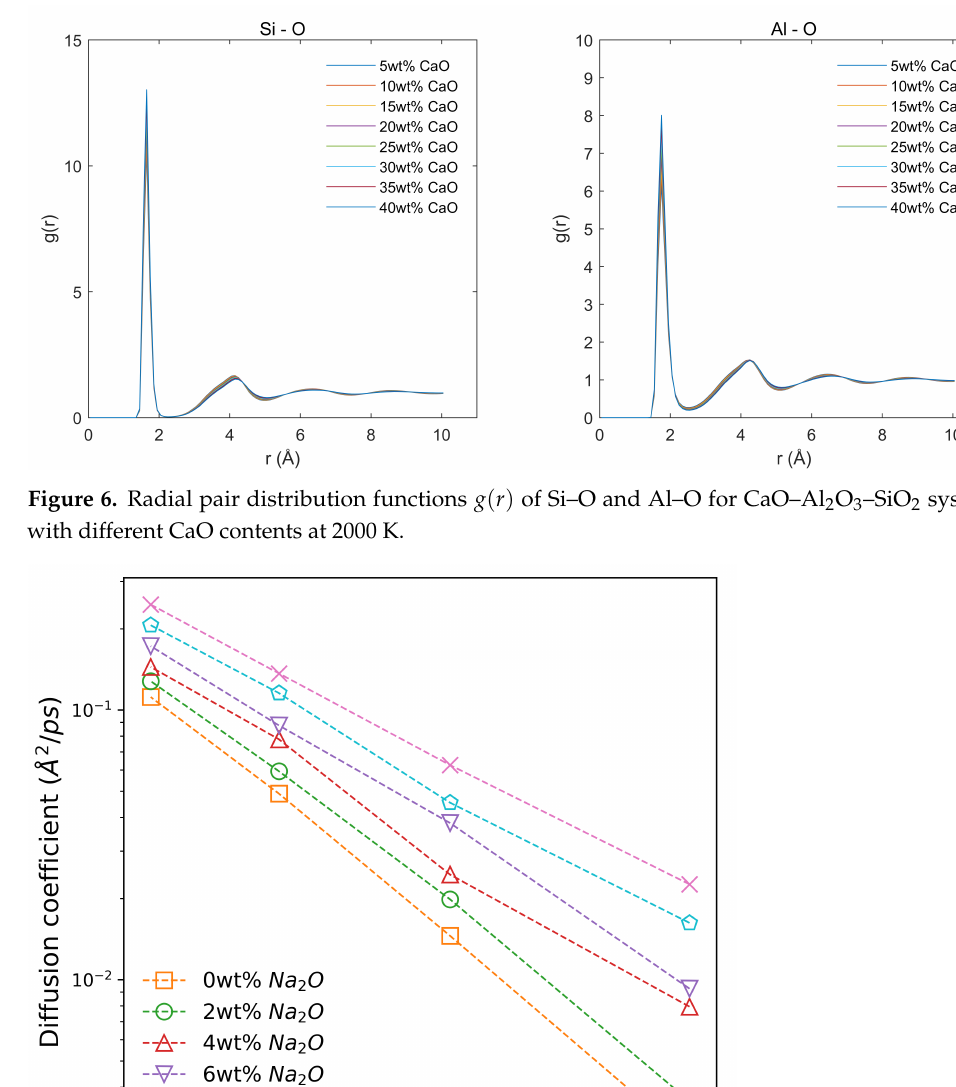
for Na 2 O–CaO–Al 2 O 3 –SiO 2 systems of T